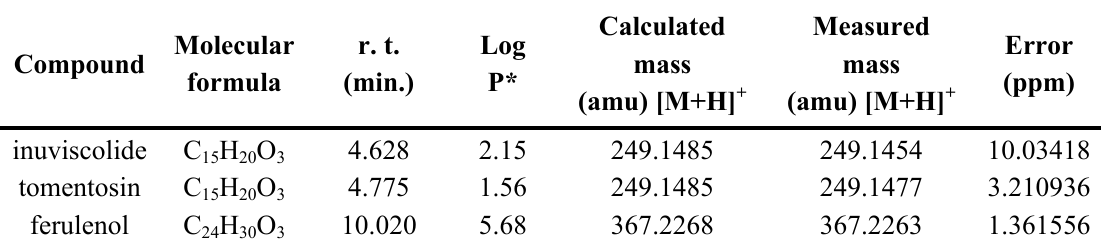
Table 3. Q-TOF (ESI + ) characteristic of inuviscolide, tomentosin, ferunelol. *calculated by Chemdraw Pro 8.0, Cambridge Soft.